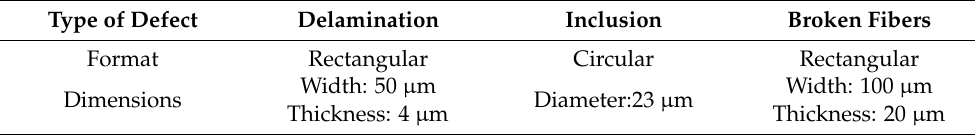
Table 3. Minimum detectable defect dimensions. Type of Defect Delamination Inclusion Broken Fibers Format Rectangular Circular Rectangular